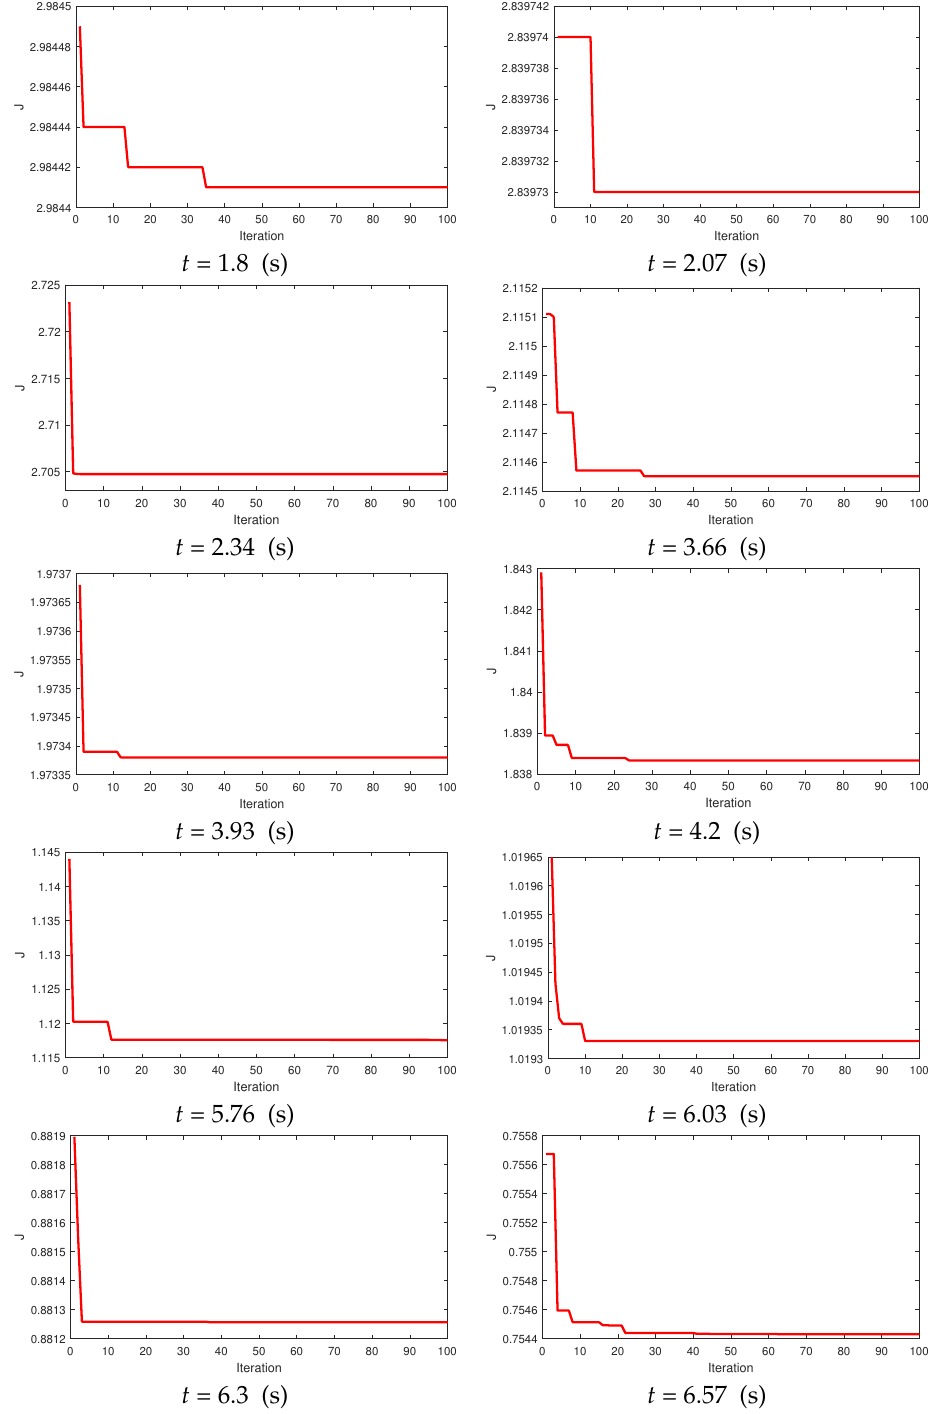
Figure 3. PSO convergence plots for different optimization processes during an arbitrary D- Bug0/PSO